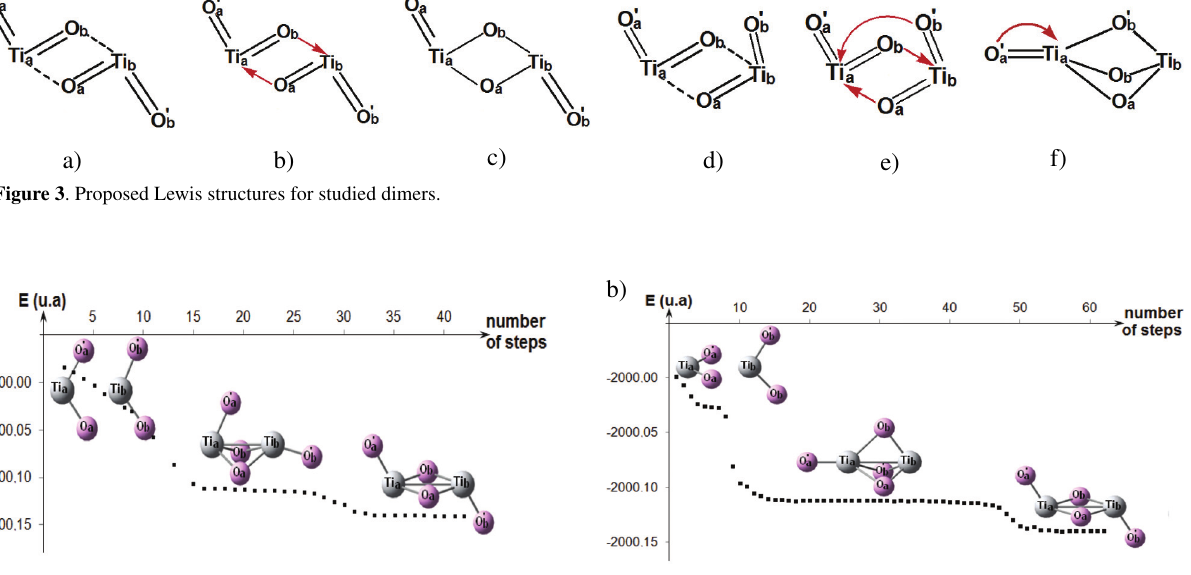
molecules: a) in parallel and b) orthogonal 2